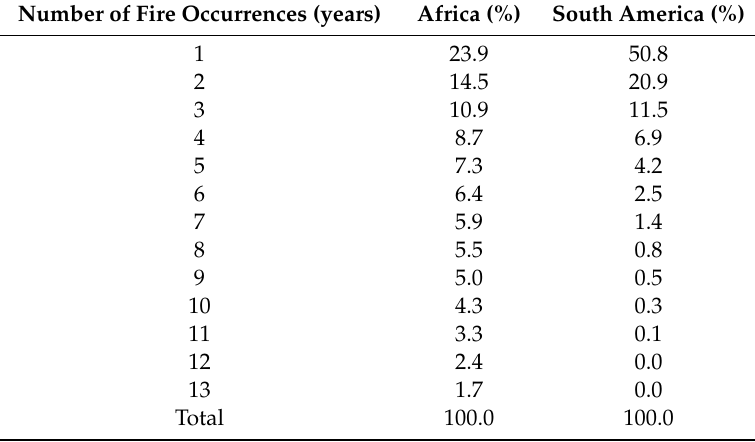
Table 1. The number of annual fire occurrences from 2001–2013 on a pixel by pixel basis for Africa and South